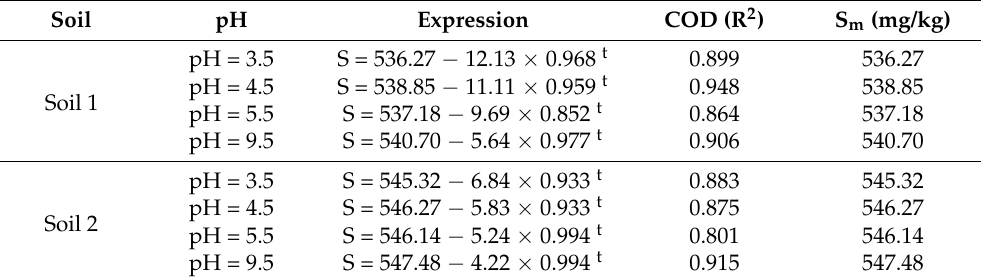
Table 3. Dynamic fitting of the exponential asymptote equation for the two soils under different solution pH